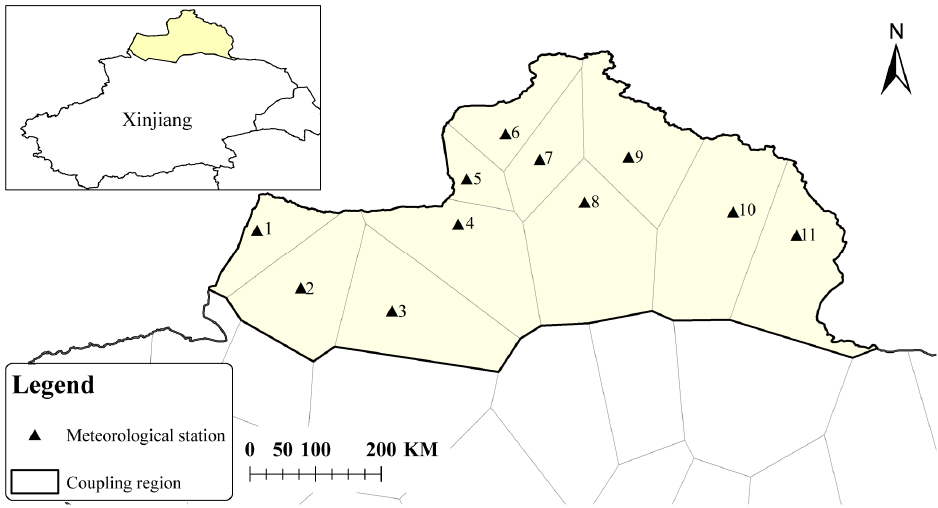
Figure 2. Sketch map of wind-speed observation station in northern Xinjiang.